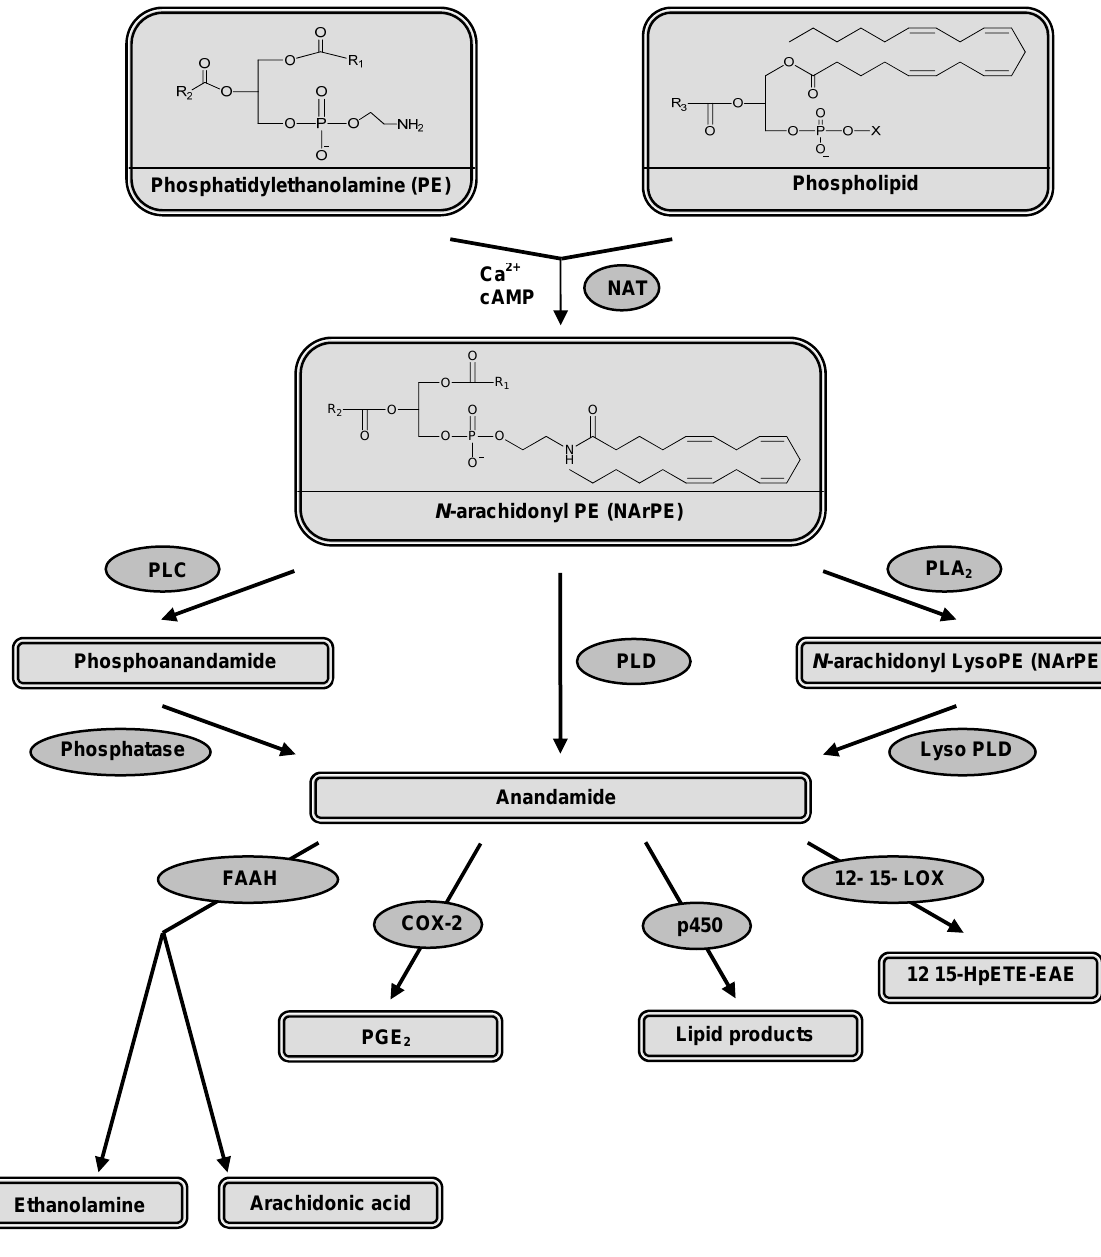
Figure 2. Enzymes involved in AEA synthesis; N -acyltransferase (NAT), protein tyrosine phosphatase (PLP) and phospholipase D (PLD) and in AEA degradation; fatty acid amide hydrolase (FAAH), cyclooxygenase-2 (COX-2), cytochrome P450, and 12-, 15-lipo- oxygenase